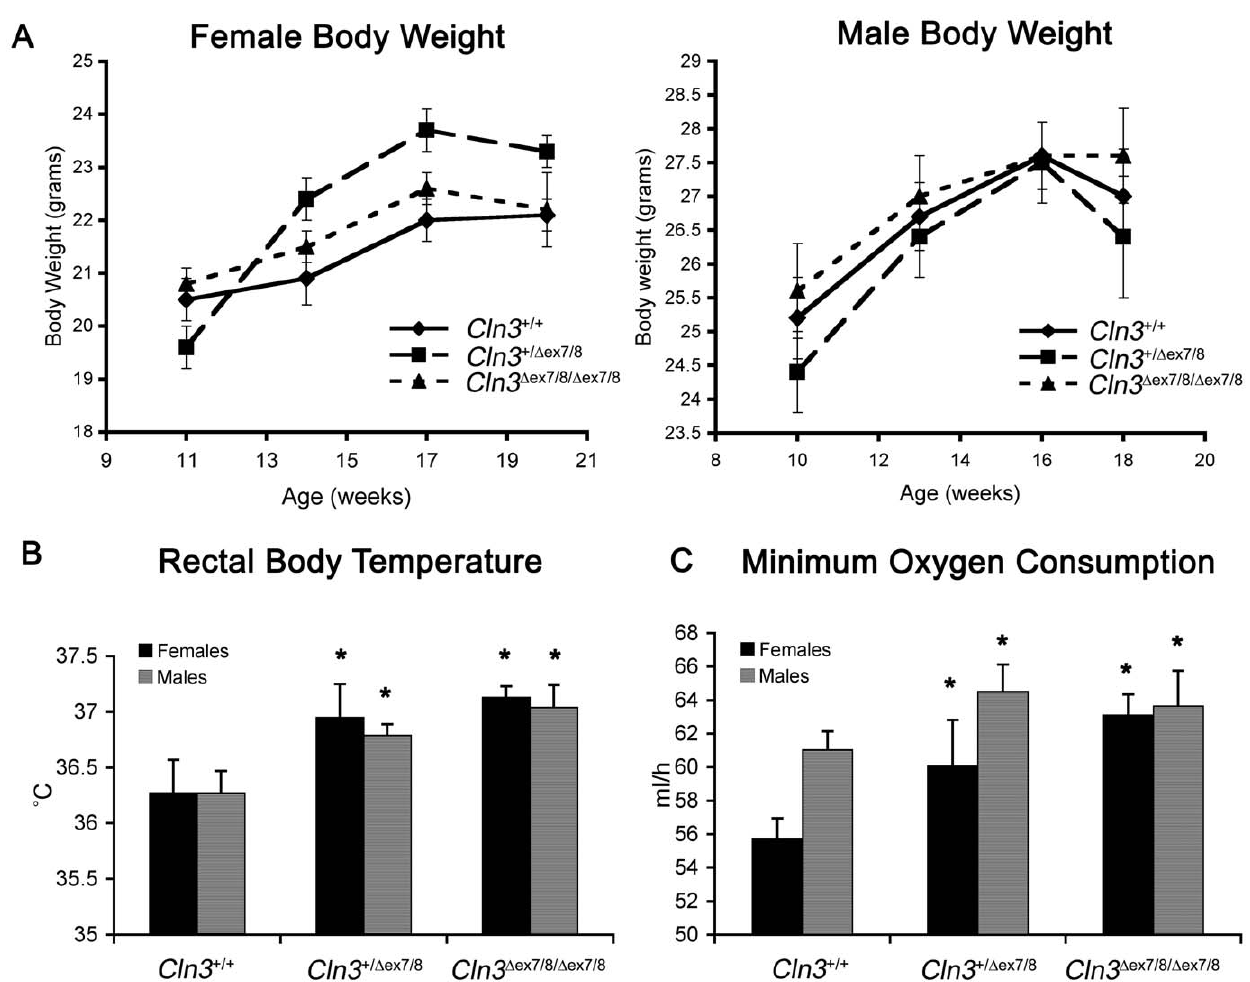
Figure 3. Metabolic abnormalities in Cln3 D ex7/8 mice. (A) Graphs depicting female (left) and male (right) mean body weight data from wild-type (diamonds), heterozygous (squares), and homozygous (triangles) Cln3 D ex7/8 mice at ages between 11 and 20-weeks are shown (n=5–10 mice per genotype/sex/age). No significant genotypic differences were observed. Error bars represent SEM. (B) Mean 6 SEM rectal body temperatures are shown for male (black bars) and female (gray bars) wild-type ( Cln3 + / + ), heterozygous ( Cln3 + / D ex7/8 ) and homozygous ( Cln3 D ex7/8/ D ex7/8 ) littermate mice are shown. Rectal body temperatures, which were measured at rest, were slightly elevated in male and female, heterozygous and homozygous Cln3 D ex7/8 mice, compared to wild-type mice. *, p , 0.001 (heterozygous versus wild-type, homozygous versus wild-type). (C) Mean 6 SEM values for minimum oxygen consumption (ml/hr) are shown for male (black bars) and female (gray bars) wild-type ( Cln3 + / + ), heterozygous ( Cln3 + / D ex7/8 ) and homozygous ( Cln3 D ex7/8/ D ex7/8 ) littermate mice are shown. Minimum oxygen consumption was elevated in male and female heterozygous and homozygous Cln3 D ex7/8 mice, compared to wild-type mice. 5–10 mice per group (genotype/sex) were analyzed. *, p , 0.001 (heterozygous versus wild- type, homozygous versus wild-type). we measured the absolute and relative counts of peripheral blood reticulocytes, red blood cell (RBC) precursors that are larger than mature RBCs. These measures were significantly higher for the homozygous Cln3 D ex7/8 mice, compared to those obtained for wild- type and heterozygous littermate mice (p= 0.01, Fig. 5B, C). Further, linear regression analysis of MCV and reticulocyte counts revealed a modest correlation between these two parameters (Fig. 5C), suggesting that the MCV increase in homozygous mutant animals is at least partly explained by the increased reticulocyte count. Other factors such as altered membrane properties in mature RBCs may also account for some of the MCV increase, although no reproducible gross differences in mature RBC morphology were noted between genotypes, and no appreciable autofluorescent or subunit c-positive storage material was detected in the RBCs (data not shown).